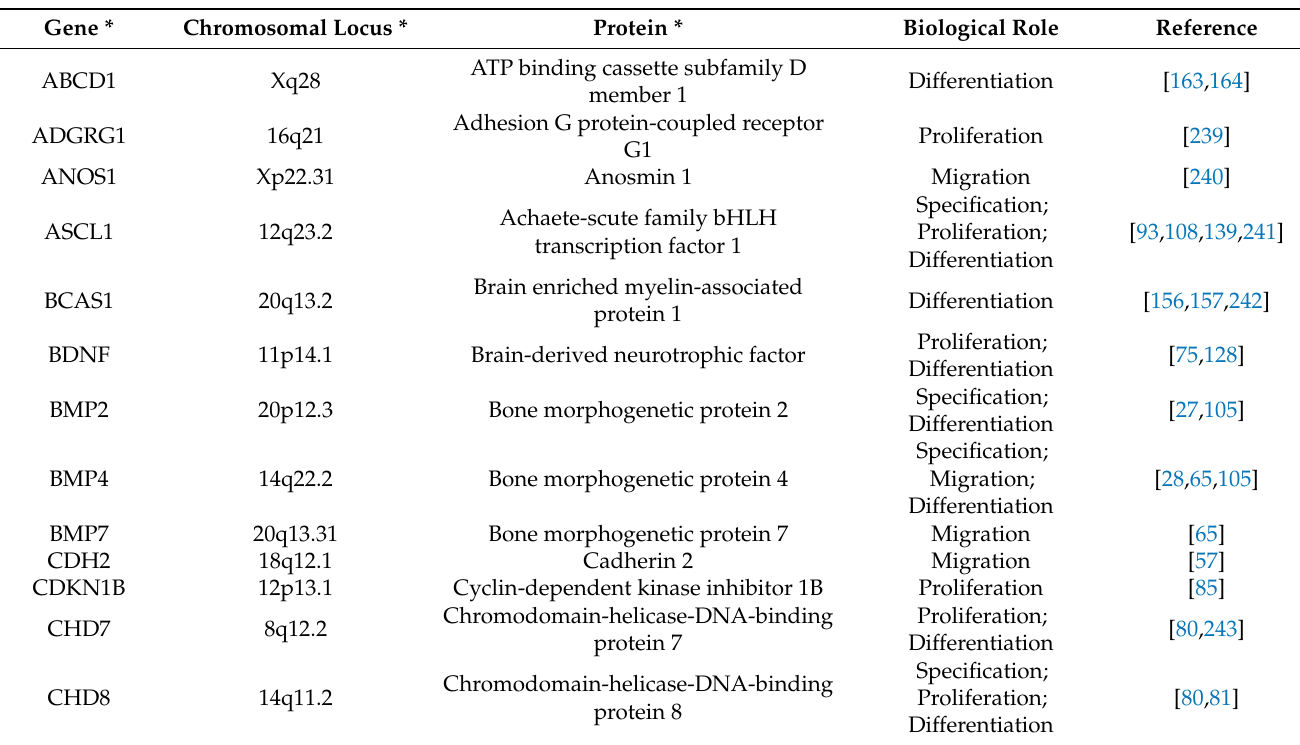
Table A1. Molecular drivers and morphogens in specification, migration, proliferation, and differen- tiation of